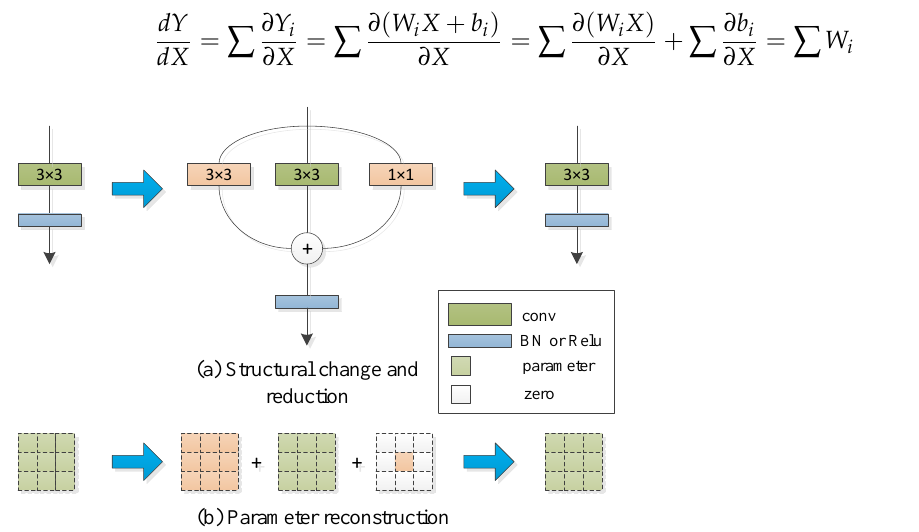
Figure 2. Visualization of training structure and inference parameter integration. ( a ) Structural change; ( b ) Parameter reconstruction.